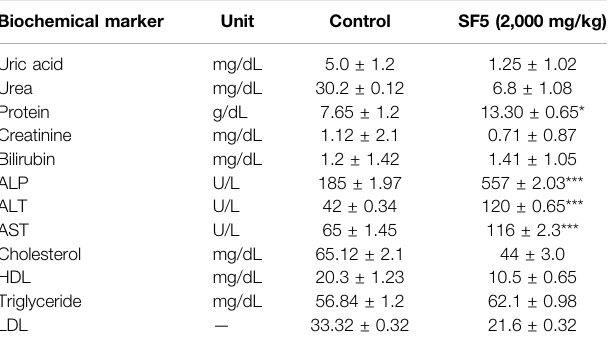
TABLE 3 | Biochemical marker analysis after SF5 treatment in the acute oral toxicity study. Biochemical